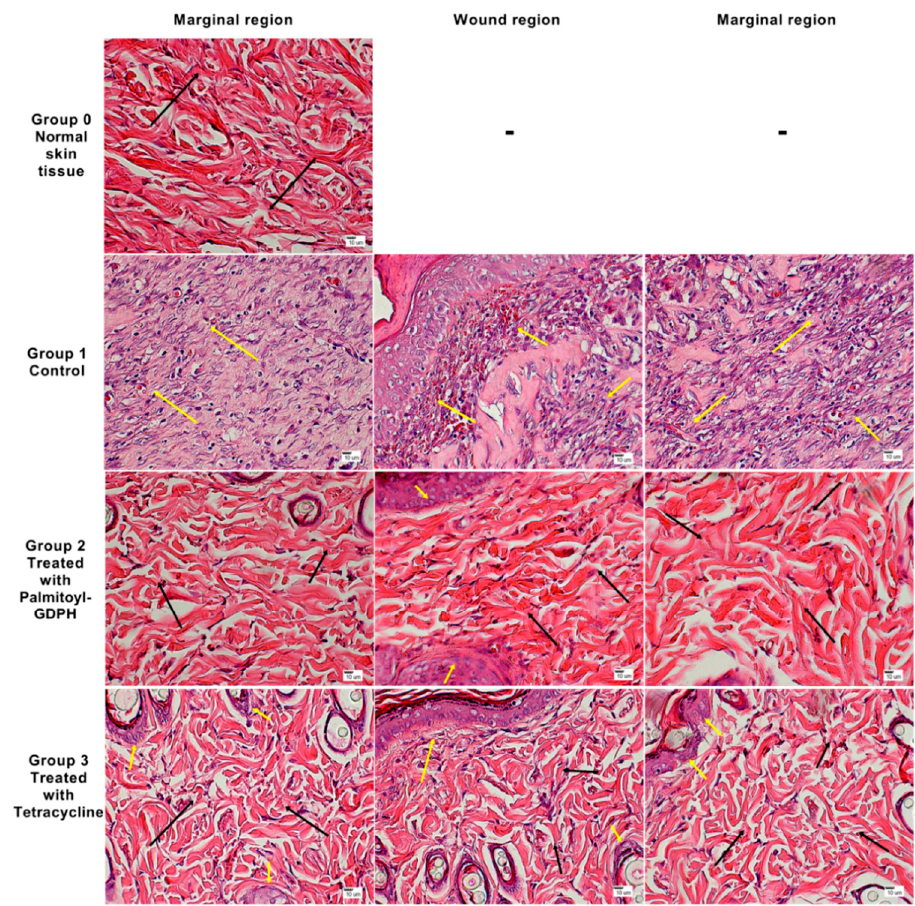
Figure 9. Photomicrograph of H & E stained rat wound section at 40 × magnification, showing regions of assessment for predominant cell types that are inflammatory cells (yellow arrow) and proliferative cells (black arrow).